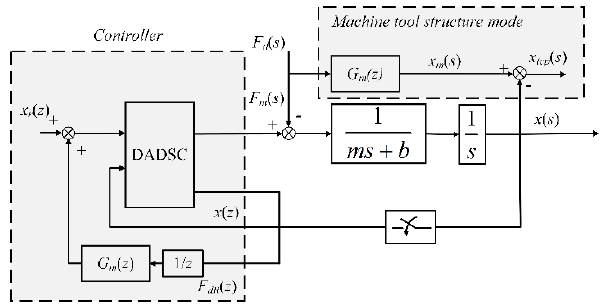
Figure 29. The block diagram of the disturbance adaptive discrete-time sliding mode controller with disturbance recovery. Reprinted with permission from ref. [125]. Copyright 2009 Elsevier Ltd.